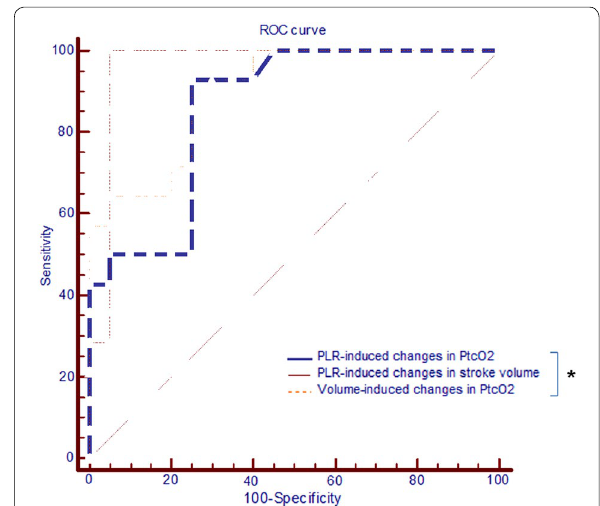
Fig. 3 Receiver-operating characteristic (ROC) curves showing the diagnostic ability of volume expansion and PLR-induced changes in PtcO 2 to predict volume responsiveness. PLR, passive leg raising. PtcO 2 , transcutaneous partial pressure of oxygen. n the comparison between areas under the